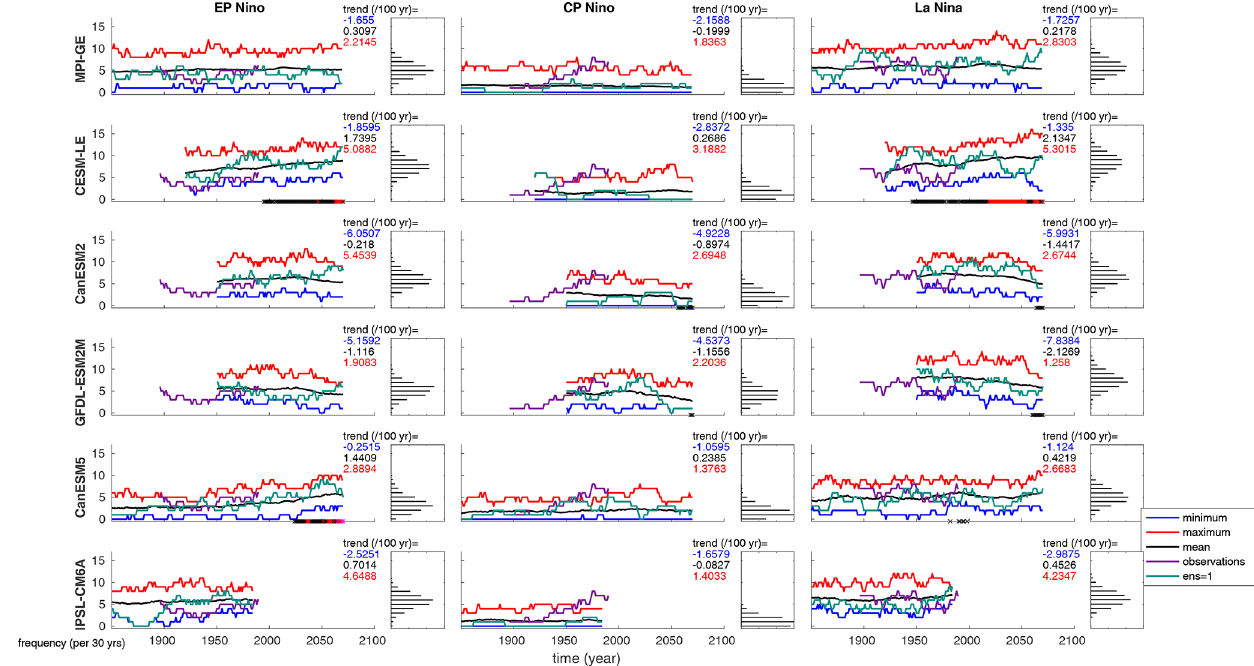
Figure 3. ENSO frequency in each SMILE for EP and CP El Niño events and for La Niña events (left, middle, and right columns respec- tively). Black line shows the ensemble mean for each year, red line shows the ensemble maximum, blue line shows the ensemble minimum, purple line represents HadISST observations, and green line is the first ensemble member. Frequency is calculated as the number of events in a single ensemble member per 30 years, taken as a running calculation along the time series. PDFs show the distribution of ensemble members for the entire time series. Black dots on the x axis demonstrate when the signal (current ensemble mean minus the ensemble mean at the beginning of the time series) is greater than the noise (standard deviation taken across the ensemble). Red dots show when the signal is 1.645 times the noise, while magenta dots show the same when the signal is greater than 2 times the noise. These thresholds correspond to the likely , very likely , and extremely likely ranges. Maximum (red), mean (black), and minimum (blue) trends across the individual ensemble members are shown in text at the top right of each panel. We note that the trends are calculated over the entirety of the simulation length for each SMILE. This means that due to the different time periods covered, trends are not directly comparable between different